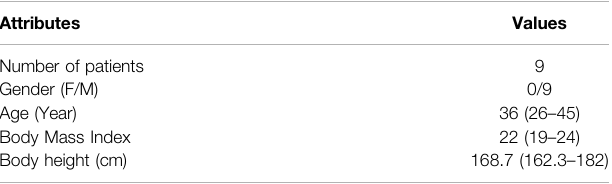
TABLE2| Thedemographicdataofcefoperazonesodiumandsulbactamsodium (3:1) clinical phase I trial. Attributes